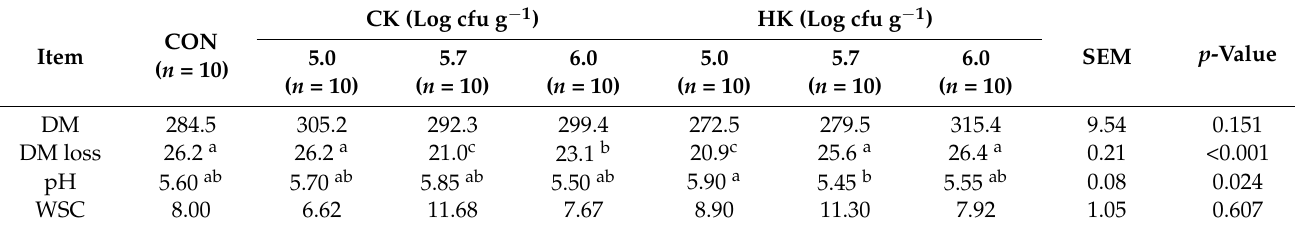
Table 1. Some chemical properties of alfalfa silage treated with different kefir sources after 45 d of ensiling.